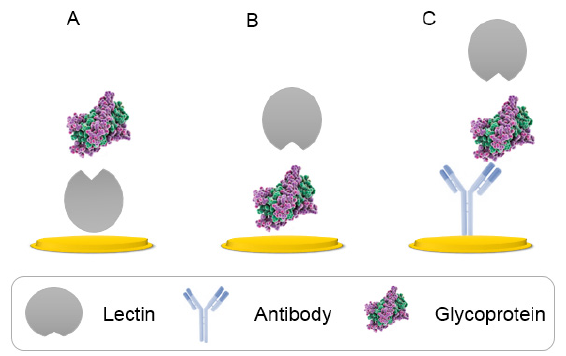
Figure 8: Configuration of lectin-based analysis with applied direct